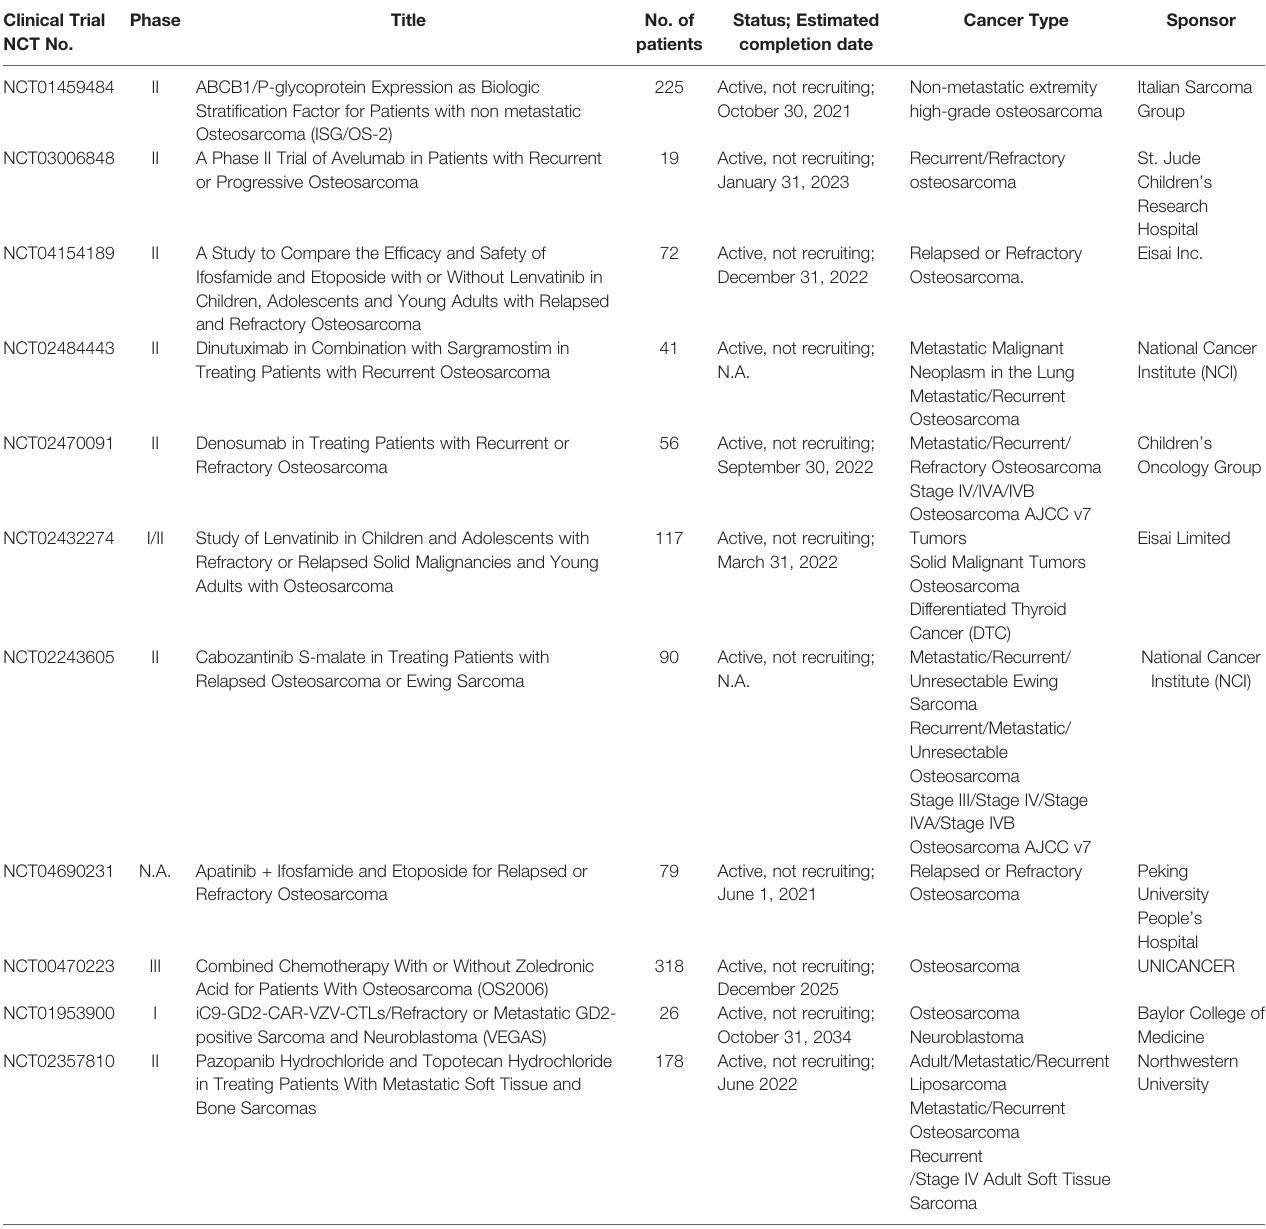
TABLE 1 | Ongoing NCT clinical trials of OS. Clinical Trial NCT